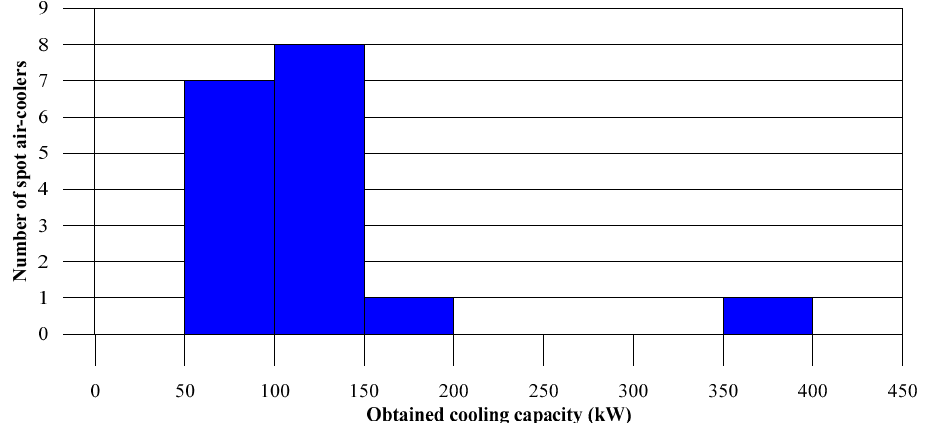
Figure 7. Bar chart of the cooling capacity of the investigated spot air-coolers of a rated cooling power, ranging 300–450 kW.